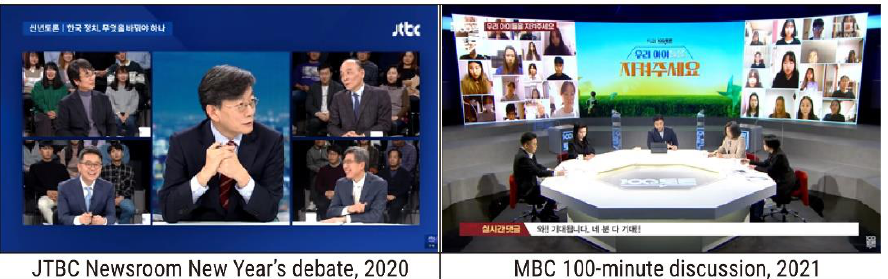
Figure 5. Examples of discussion type broadcasting.